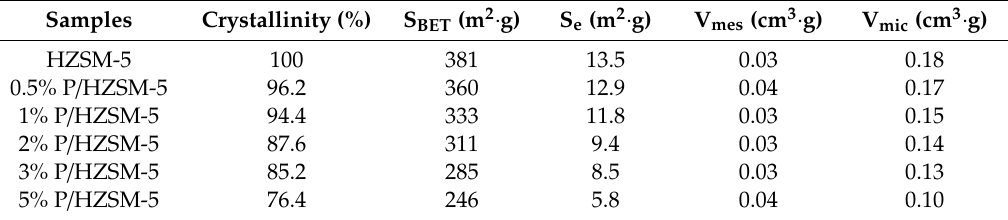
Figure 1. XRD patterns of the different catalysts: ( a ) HZSM-5, ( b ) 0.5% P/HZSM-5, ( c ) 1% P/HZSM-5, ( d ) 2% P/HZSM-5, ( e ) 3% P/HZSM-5 and ( f ) 5% P/HZSM-5. Table 1. Textural properties of parent and P-modified HZSM-5 samples.